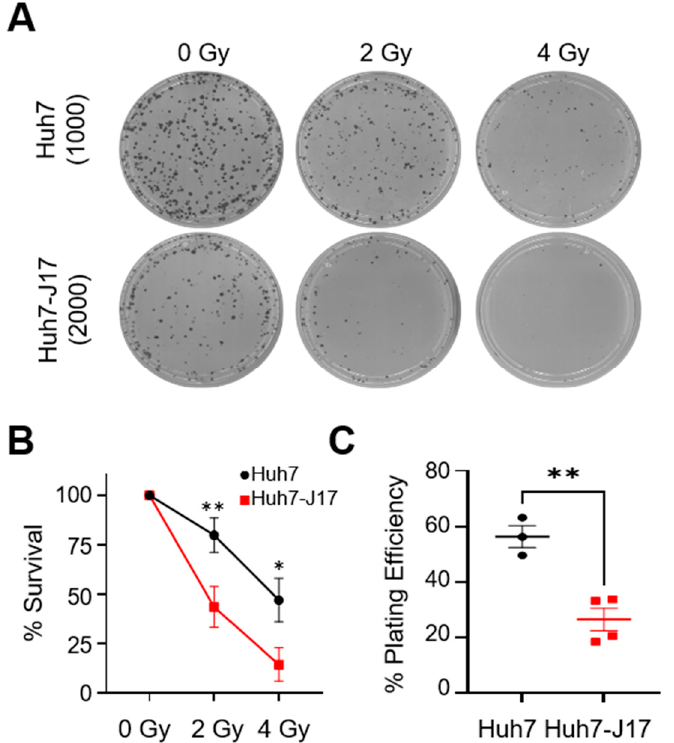
Figure 3. HCV impairs DNA damage repair pathways in Huh7 cells. Plates representing colonies formed without any treatment (0 Gy) and after cells were exposed to 2 Gy or 4 Gy X-ray radiation, as visualised by crystal violet stain. Image is representative of 3 independent repeats done in duplicates. Numbers represent initial cells seeded ( A ). % clonogenic cell survival plots ( B ) and plating efficiency % ( C ) of Huh7 and Huh7-J17 cells, indicating the increased sensitivity of cells to irradiation in the presence of Hepatitis C Virus (HCV). * p < 0.05, ** p < 0.01. 2-way ANOVA with Tukey’s multiple test correction ( B ) and unpaired t -test ( C